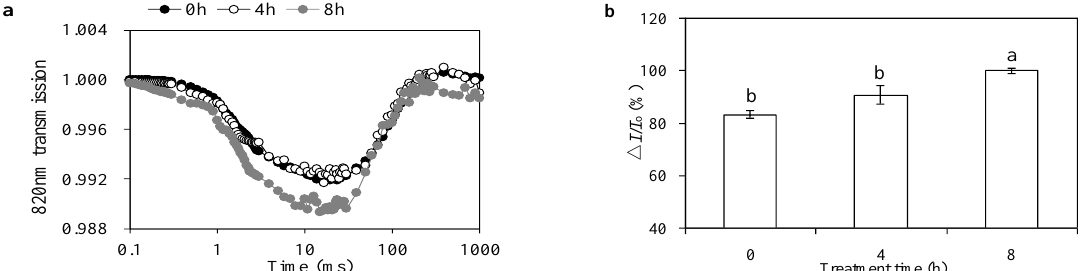
Figure 6. Effects of PSI activity. ( a ) Changes in light transmission at 820 nm, ( b ) Relative values of ∆ I/I o in leaves of mulberry seedlings exposure to 4 µ L · L − 1 NO 2 for 0 h, 4 h (4 h · d − 1 , for one day), and 8 h (4 h · d − 1 , for 2 days), where the ∆ I / I o values at 8 h were taken as 100%. Date represent means of four plants ± standard deviations. Different lowercase letters for the same parameter indicate significant differences among different treatments at p < 0.05 levels.